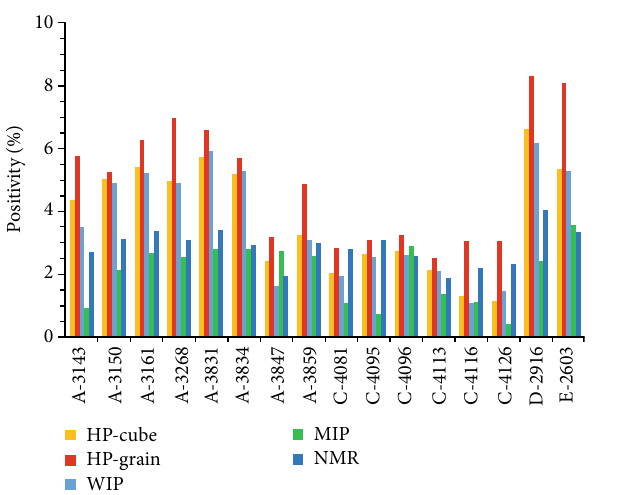
Figure 6: Porosities from NMR tests with di ff erent experimental